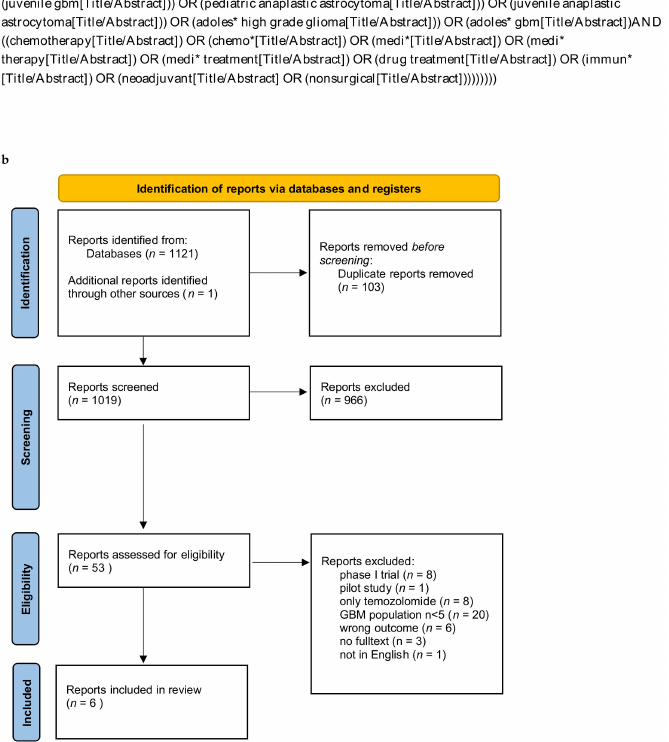
Figure 2. ( a ) Systematic search string used for Pubmed database. Adjustments of format have been made according to Embase guidelines. ( b ) PRISMA flow diagram (2020) for systematic